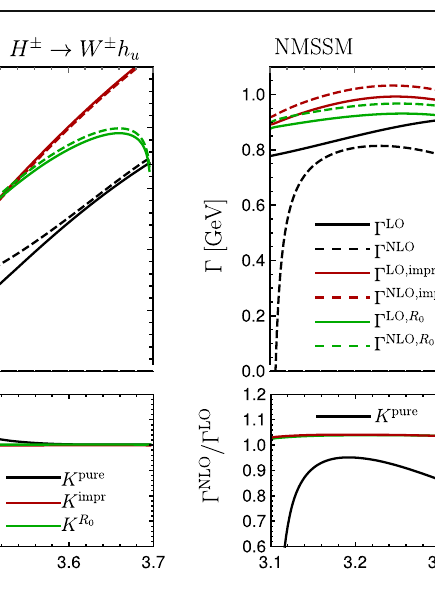
ing the Z matrix (red) and the R 0 matrix (green), as a function of tan β . Lower panels: corresponding K